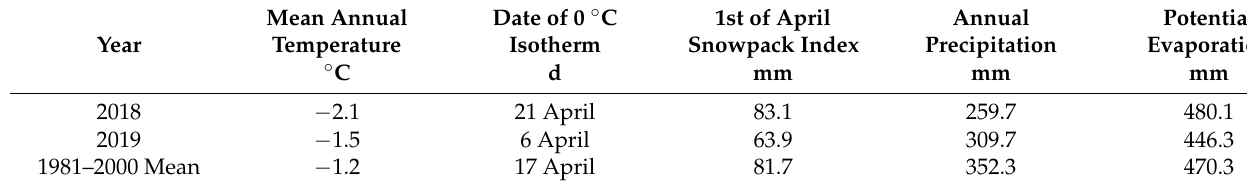
Table 2. Hydrometeorological indices based on Fort Chipewyan (Alberta) data.